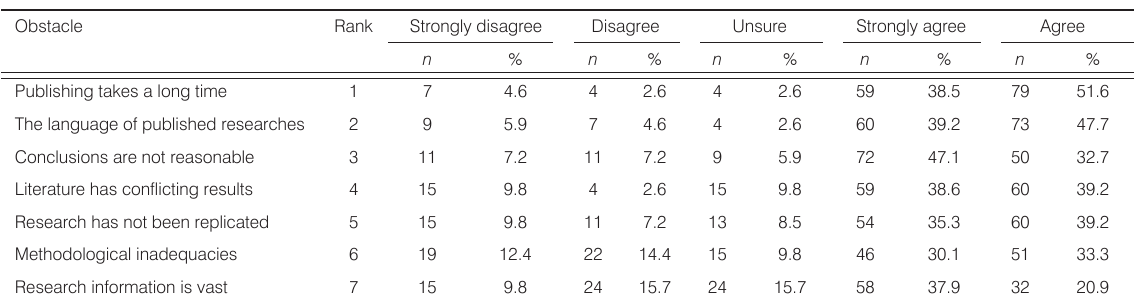
Table 4. Distribution of study sample regarding research quality (N=154).